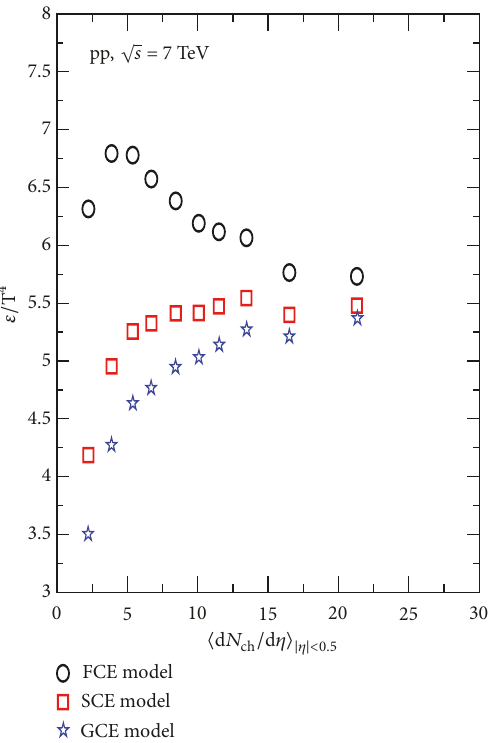
Figure 2: The energy density 𝜀/𝑇 4 obtained for three different